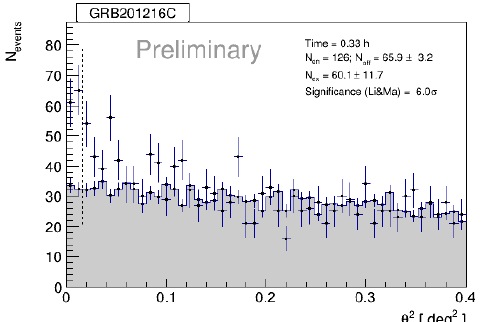
Figure 27. θ 2 angular distance distribution between reconstructed event arrival directions and nominal source position for GRB201216C. The gray histogram represents background events while the black point with blue crosses are the γ -like events. The vertical dashed line describes the θ 2 cut value and defines the region in which excess events and signal significance are calculated. From